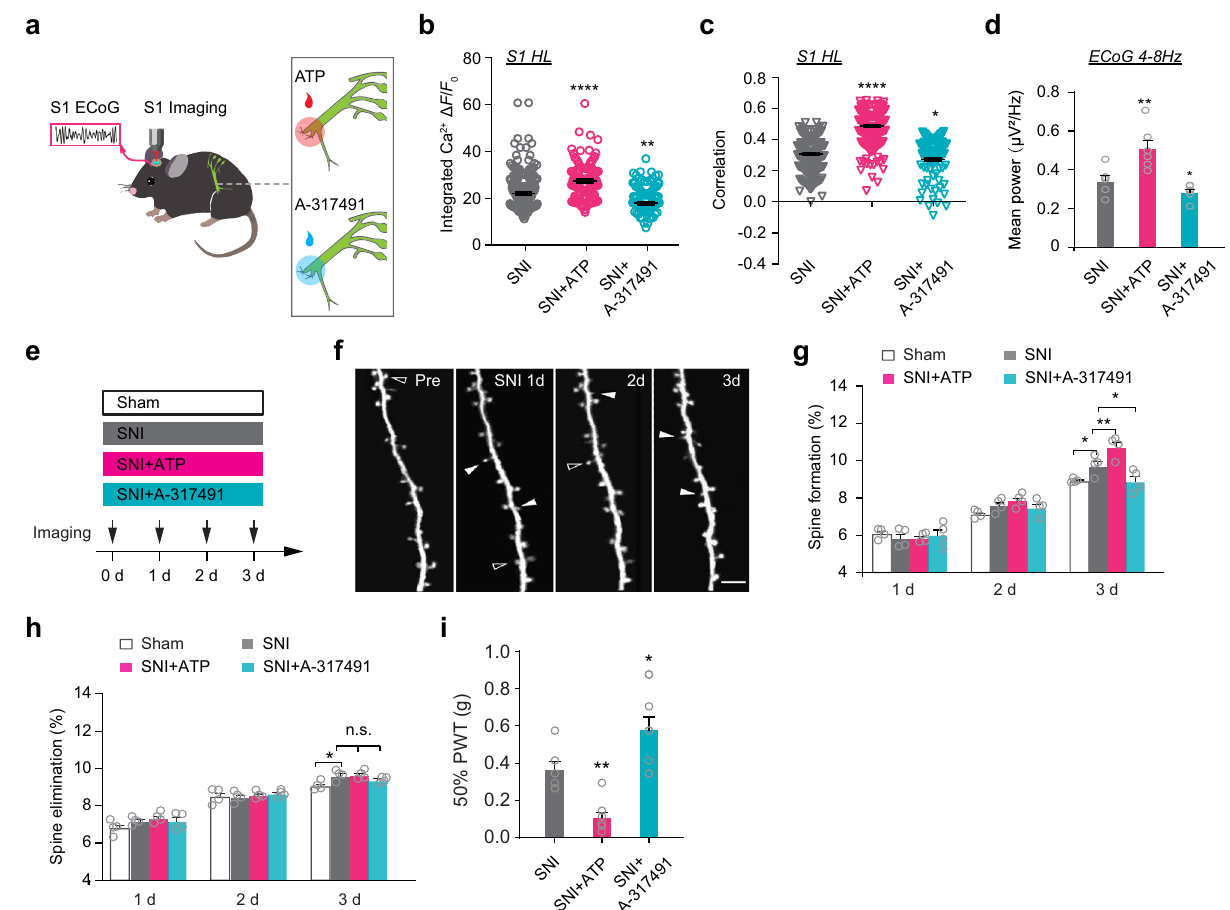
Fig. 5 | ATP-dependent activity synchrony of DRG neurons is critical for synapticremodelinginS1.a SchematicofCa 2+ imagingofL2/3pyramidalneurons and ECoG recording in S1ofinmiceat3 days after SNI surgery. The inset indicates SNIsurgeryandlocalapplicationofATPorA-317491tosciaticnerve. b , c Integrated Ca 2+ activity ( b ) and correlation coef fi cient ( c ) of L2/3 pyramidal neurons in S1 and ECoG theta band power ( d ) at 3 days afterSNI, plus application ofATP or A-317491 over 3 days after SNI. e Schematic of experimental design in panels f – h . Apical dendritic spines of L5 pyramidal neurons in S1 were imaged daily for 4 days. f Representative images of dendritic spines on apical tuft dendrites of layer 5